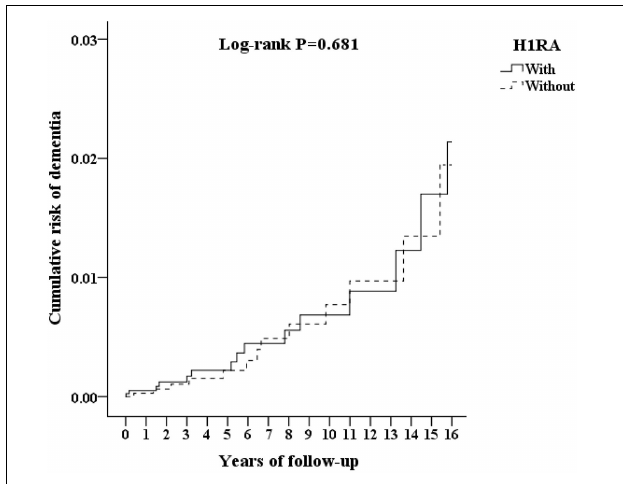
FIGURE 2 | Kaplan–Meier for cumulative risk of dementia aged 50 and over stratified by H1RA (histamine type 1 antagonist) with log-rank test.